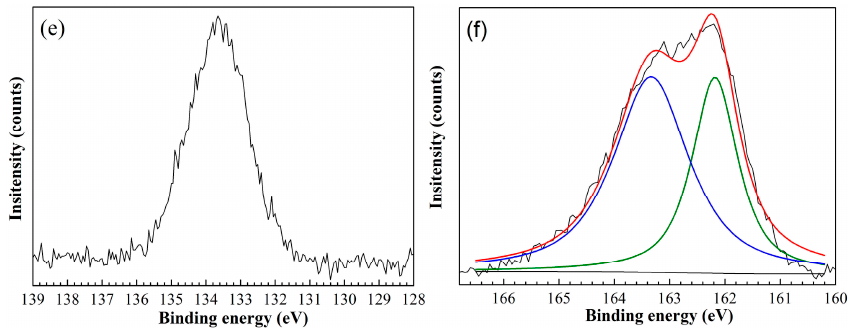
Figure 2. X-ray photoelectron spectroscopy (XPS) spectra of major elements on copper surface treated with H 3 PO 4 solution and modified with 1-dodecanethiol SAM: ( a ) XPS; ( b ) C 1 s ; ( c ) Cu 2 p ; ( d ) O 1 s ; ( e ) P 2 p ; and ( f ) S 2 p .